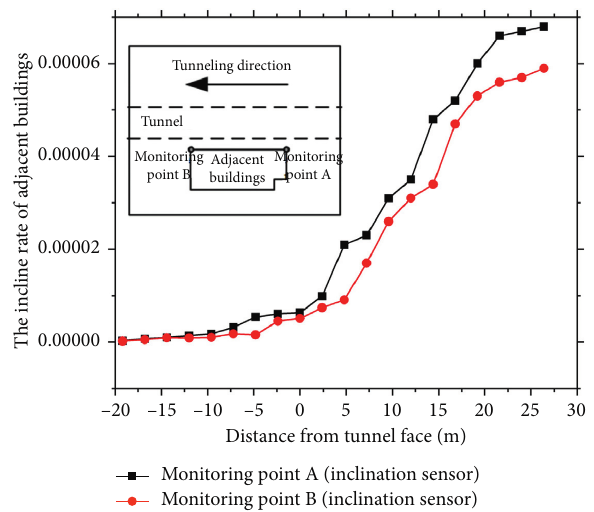
Figure 7: Change of inclination angle of adjacent buildings per- pendicular to tunnel